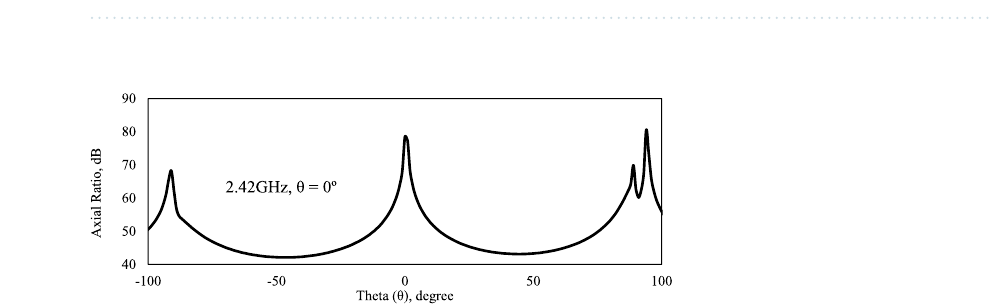
Table 3. Results of measured monopole antennas.